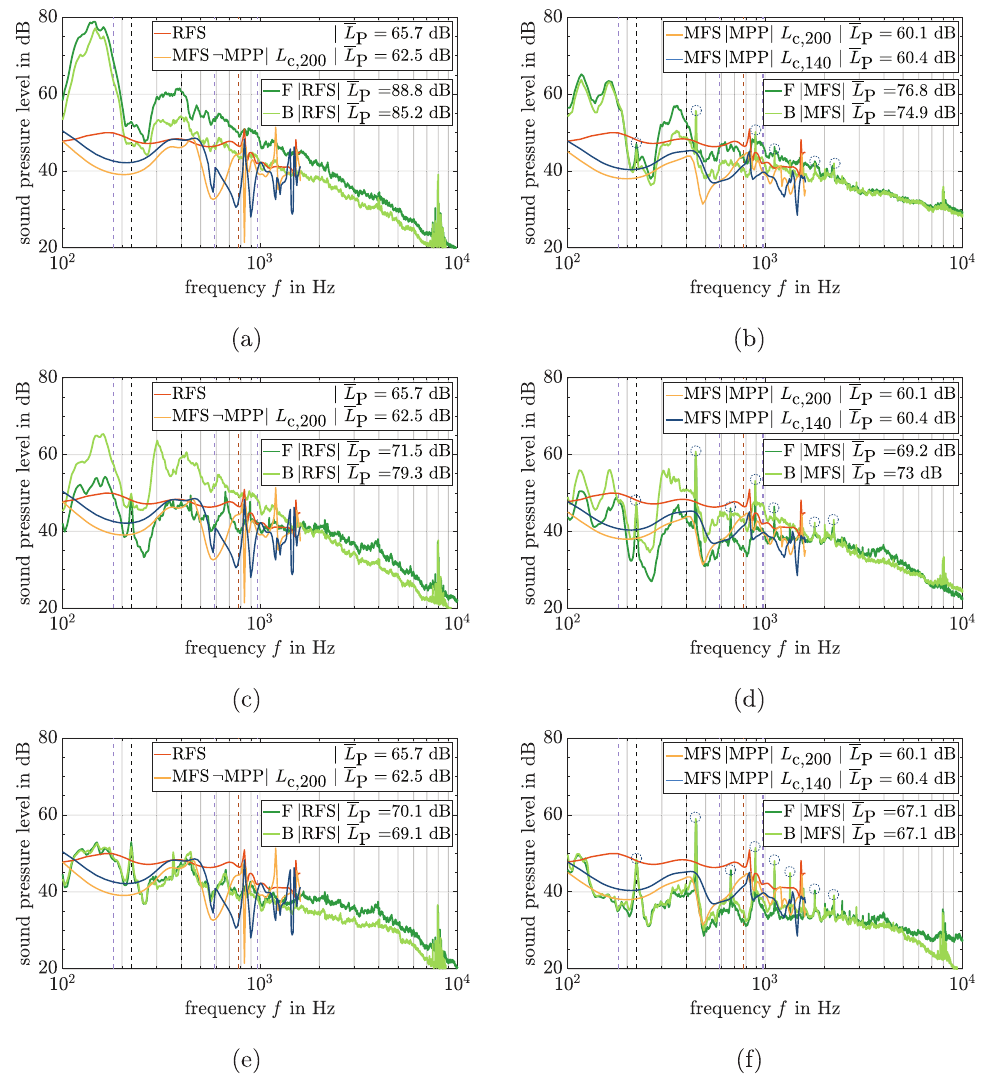
Figure 12. Measured and simulated sound emission spectra of the RFS-MFS con fi guration; (a, c, e) show simulated cases without MPP and in (b, d, f) the MPP is added. (a) RFS emission spectrum at 0.8 m 3 s (cid:4) 1 . (b) MFS emission spectrum at 0.8 m 3 s (cid:4) 1 . (c) RFS emission spectrum at 1.4 m 3 s (cid:4) 1 . (d) MFS emission spectrum at 1.4 m 3 s (cid:4) 1 . (e) RFS emission spectrum at 1.9 m 3 s (cid:4) 1 . (f) MFS emission spectrum at 1.9 m 3 s (cid:4) 1